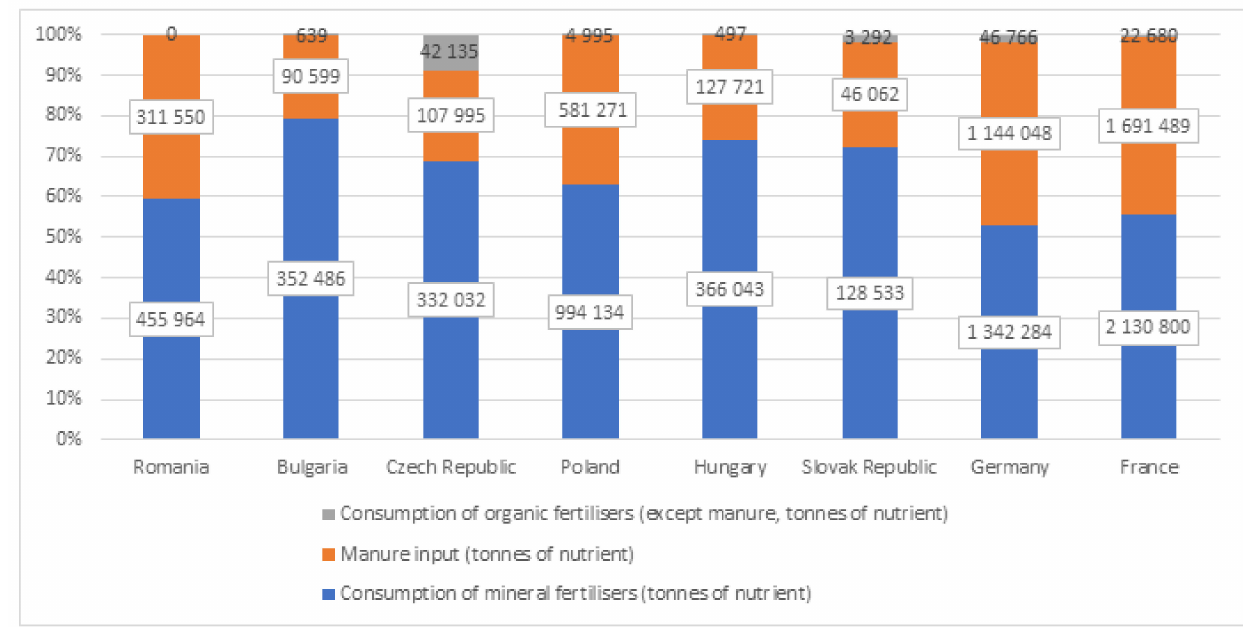
Figure 1. Total consumption of nitrogen fertilisers (2019, tonnes). Source: own calculation based on